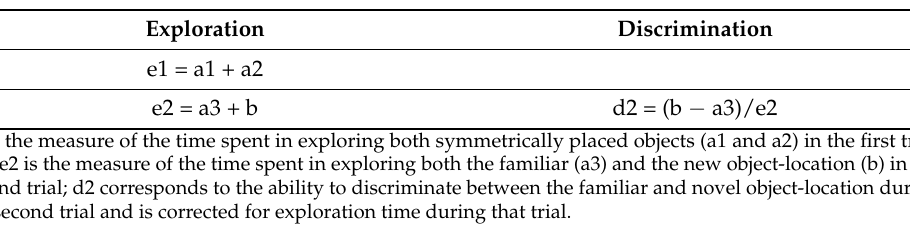
Table 1. Measures involved in the object location test (OLT).